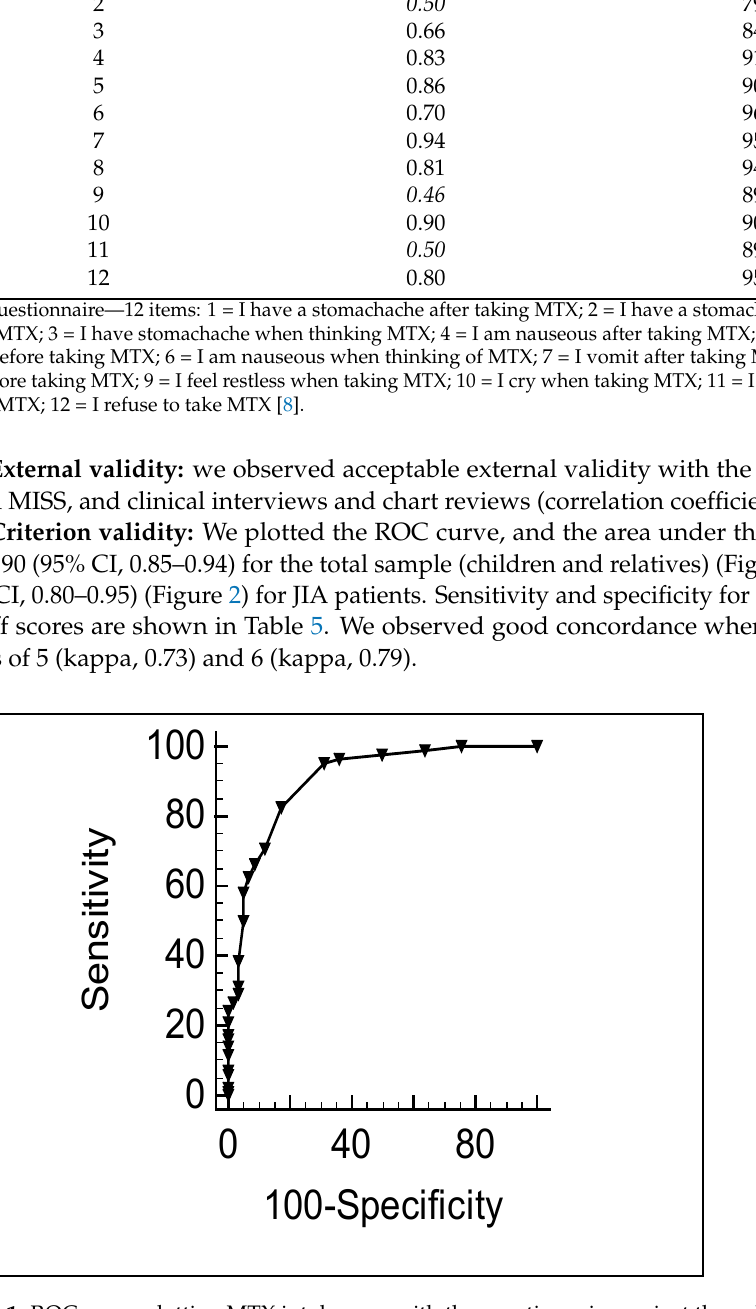
Figure 2. ROC curve plotting MTX intolerance with the questionnaire against the gold standard with cut-off score of 5 in JIA patients. AUC = 0.89 (95% CI, 0.80–0.95). Principal component analysis: the two first components were responsible for 54% of the observed variability, as shown in Figure 3.